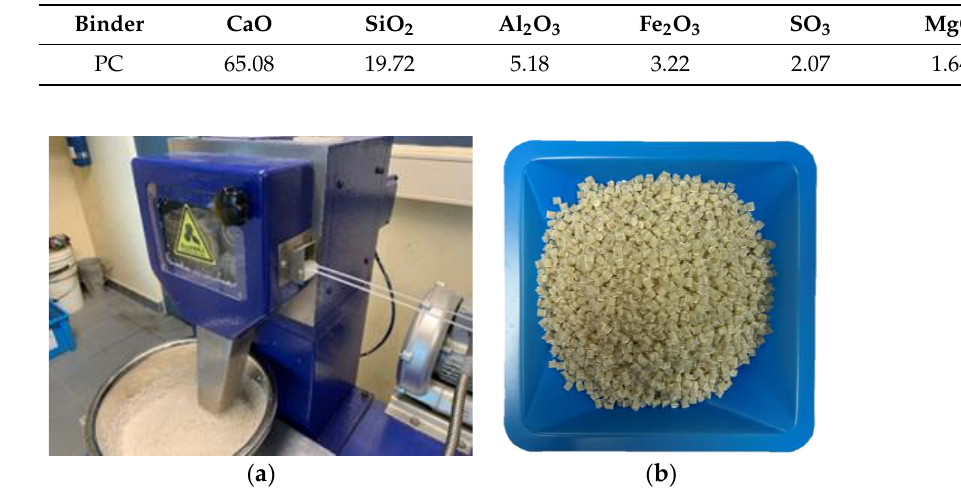
Table 1. Chemical composition of PC (wt%).